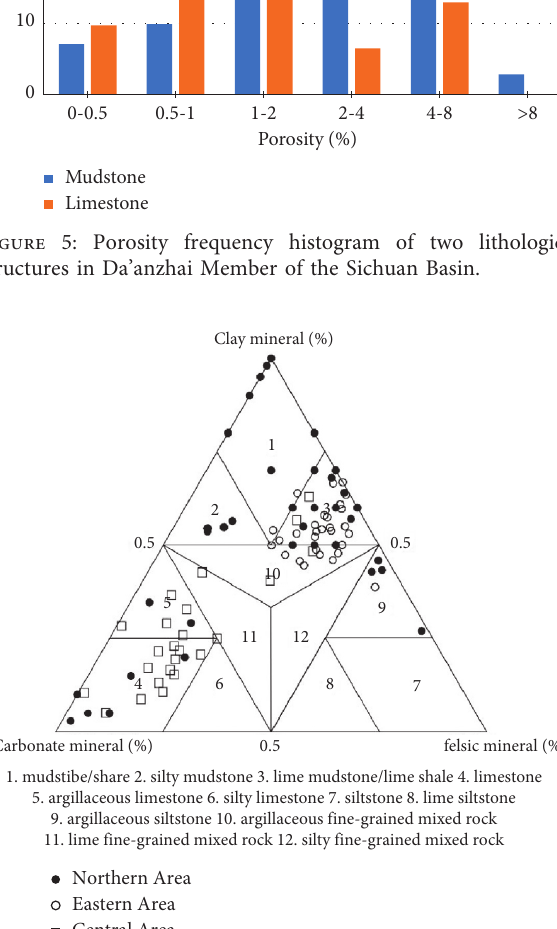
Figure 6: Fine-grained sedimentary rock classification schemes of Da’anzhai member of Jurassic in Sichuan